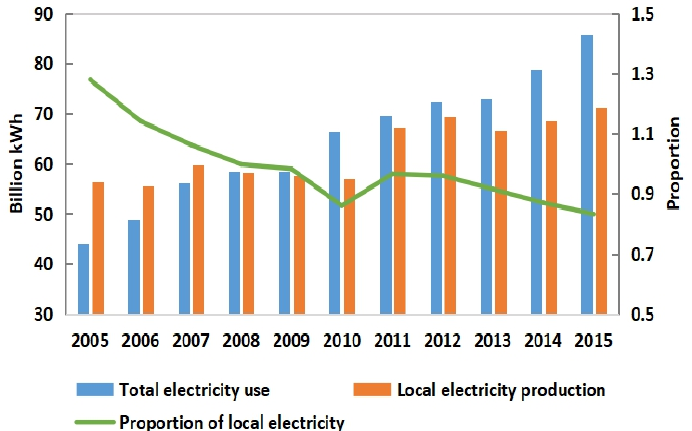
Figure 3. Local electricity generation and its proportion to total electricity use in Shenzhen during 2005–2015.